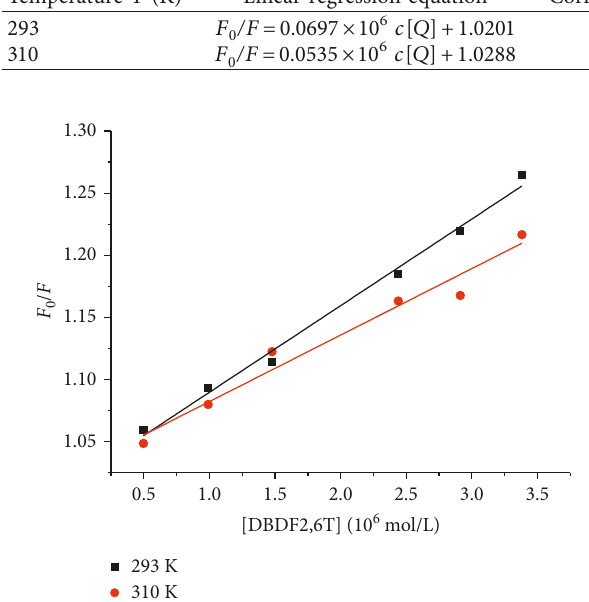
Table 1: Linear regression equations and Stern–Volmer quenching rate constants at different temperatures. Temperature T (K)